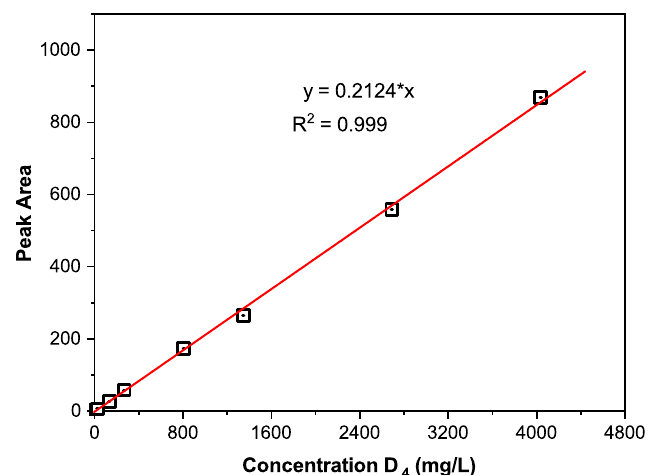
Figure 4. The calibration curve for D 4 in n-hexane: GC peak area as a function of D 4 concentration. Using Equation (1) for further calculation, as shown in Figure 5 (upper), the concen- trations of cyclic siloxanes with a low repeat unit (D 4 –D 9 ) decrease after UVA irradiation, while the concentrations of the larger cyclic siloxanes (D 10 –D 19 ) remain almost